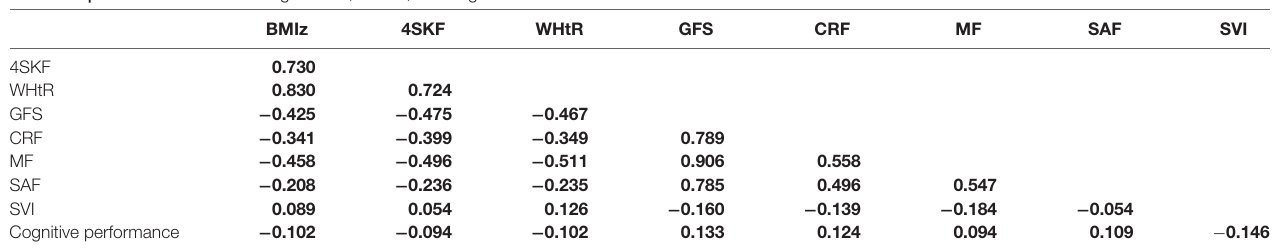
TABLE 2 | Correlation matrix among fatness, fitness, and cognition variables.